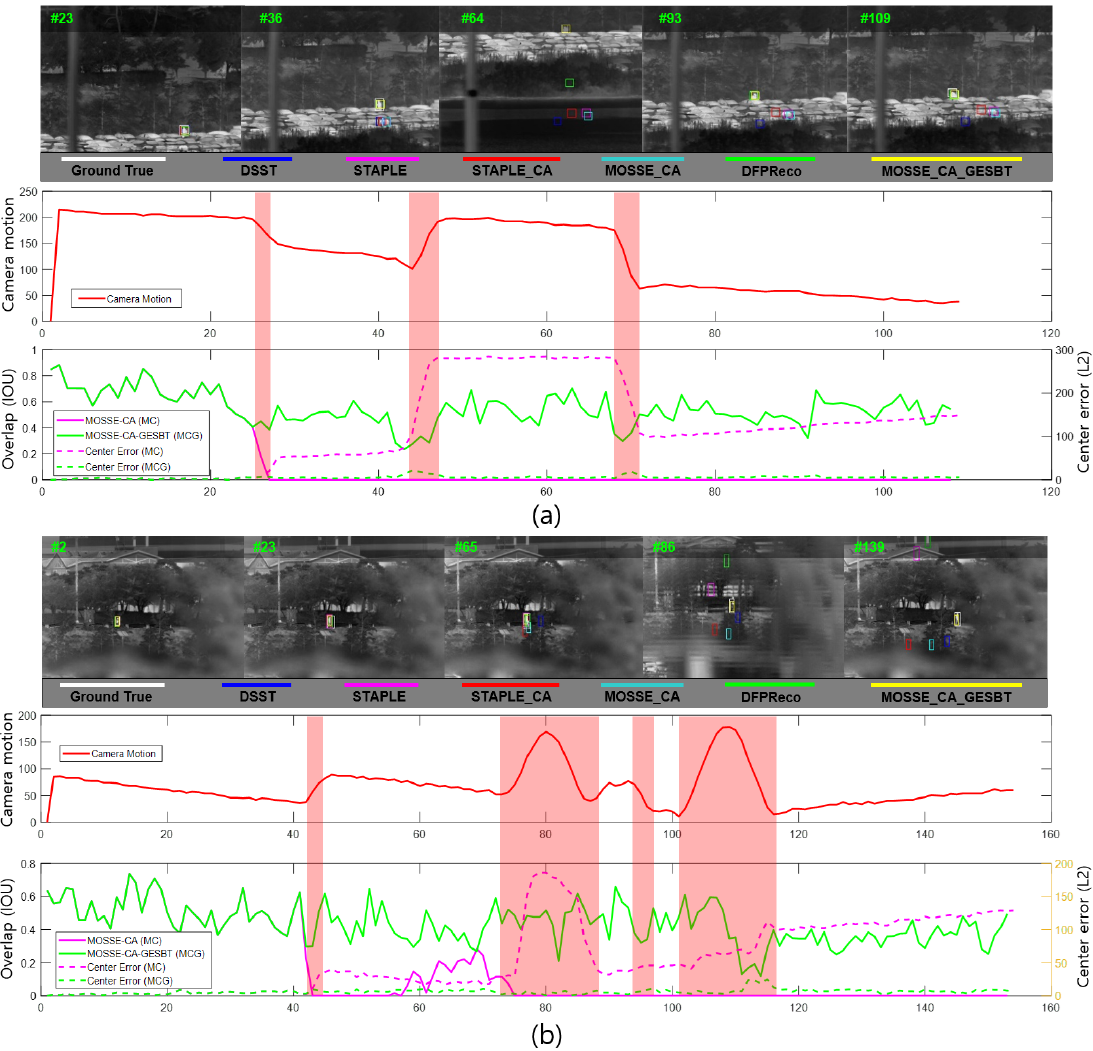
Figure 14. Comparison of the proposed tracker with the conventional tracker. The red solid line on the camera motion graph shows a representative x-axis motion profile. Green and magenta solid lines are the IOU measurement results of the conventional tracker (MOSSE_CA) and the proposed tracker (MOSSE_CA + GESBT). The dotted lines show the center error measurement results of MOSSE_CA and the proposed tracker. ( a ) Tracking result of EOTS_parking dataset; ( b ) tracking result of EOTS_6DOF_up_down